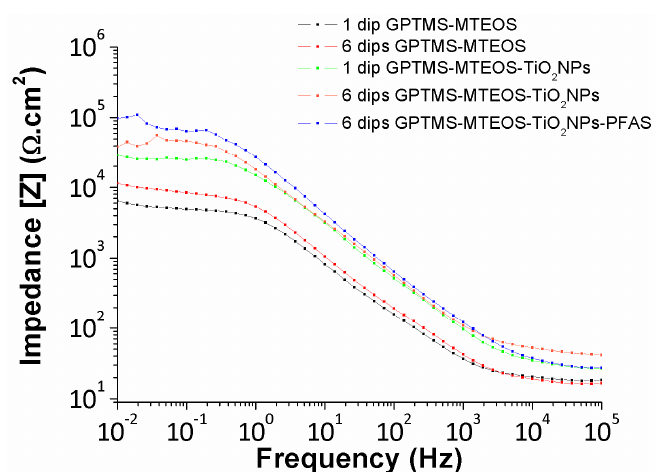
Figure 12. Bode plots of several sol-gel hybrid coatings (GPTMS-MTEOS, GPTMS-MTEOS-TiO 2 NPs, and GPMTS-MTEOS-TiO 2 NPs-PFAS) as a function of the number of dips after immersion in 3.5% NaCl solution for a fixed period of 168 h.